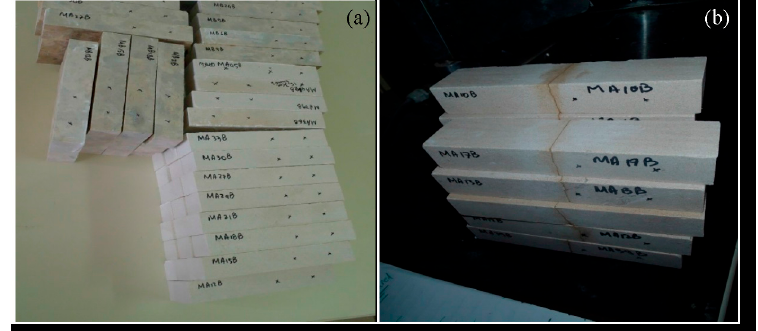
Figure 3. The population of ( a ) healthy and ( b ) repaired specimens for MA marble.